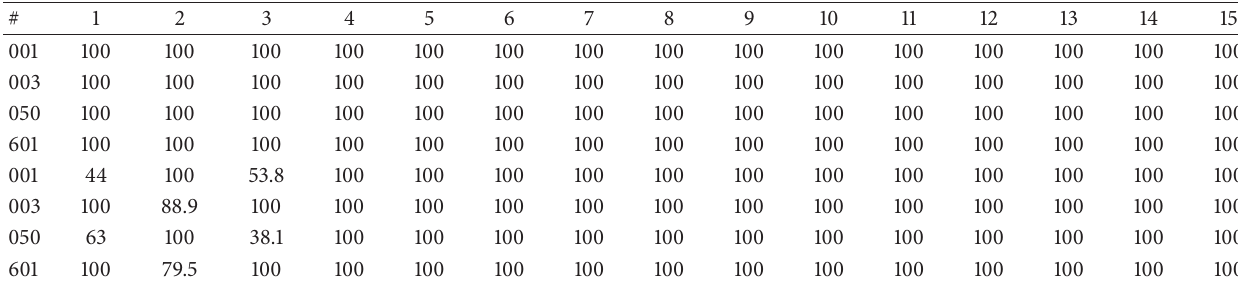
Table 9: Bit error rates of proposed method.